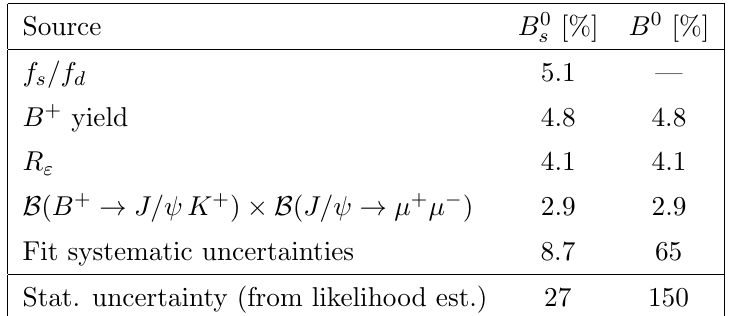
Table 3. Breakdown of the expected systematic uncertainties in B ( B 0 ments are dominated by statistical uncertainty, followed by the systematic uncertainty from the (cid:12)t. The latter is dominated by contributions from the mass scale uncertainty and the parameter- isation of the b ! (cid:22) + (cid:22) (cid:0) X background. The statistical uncertainties reported here are